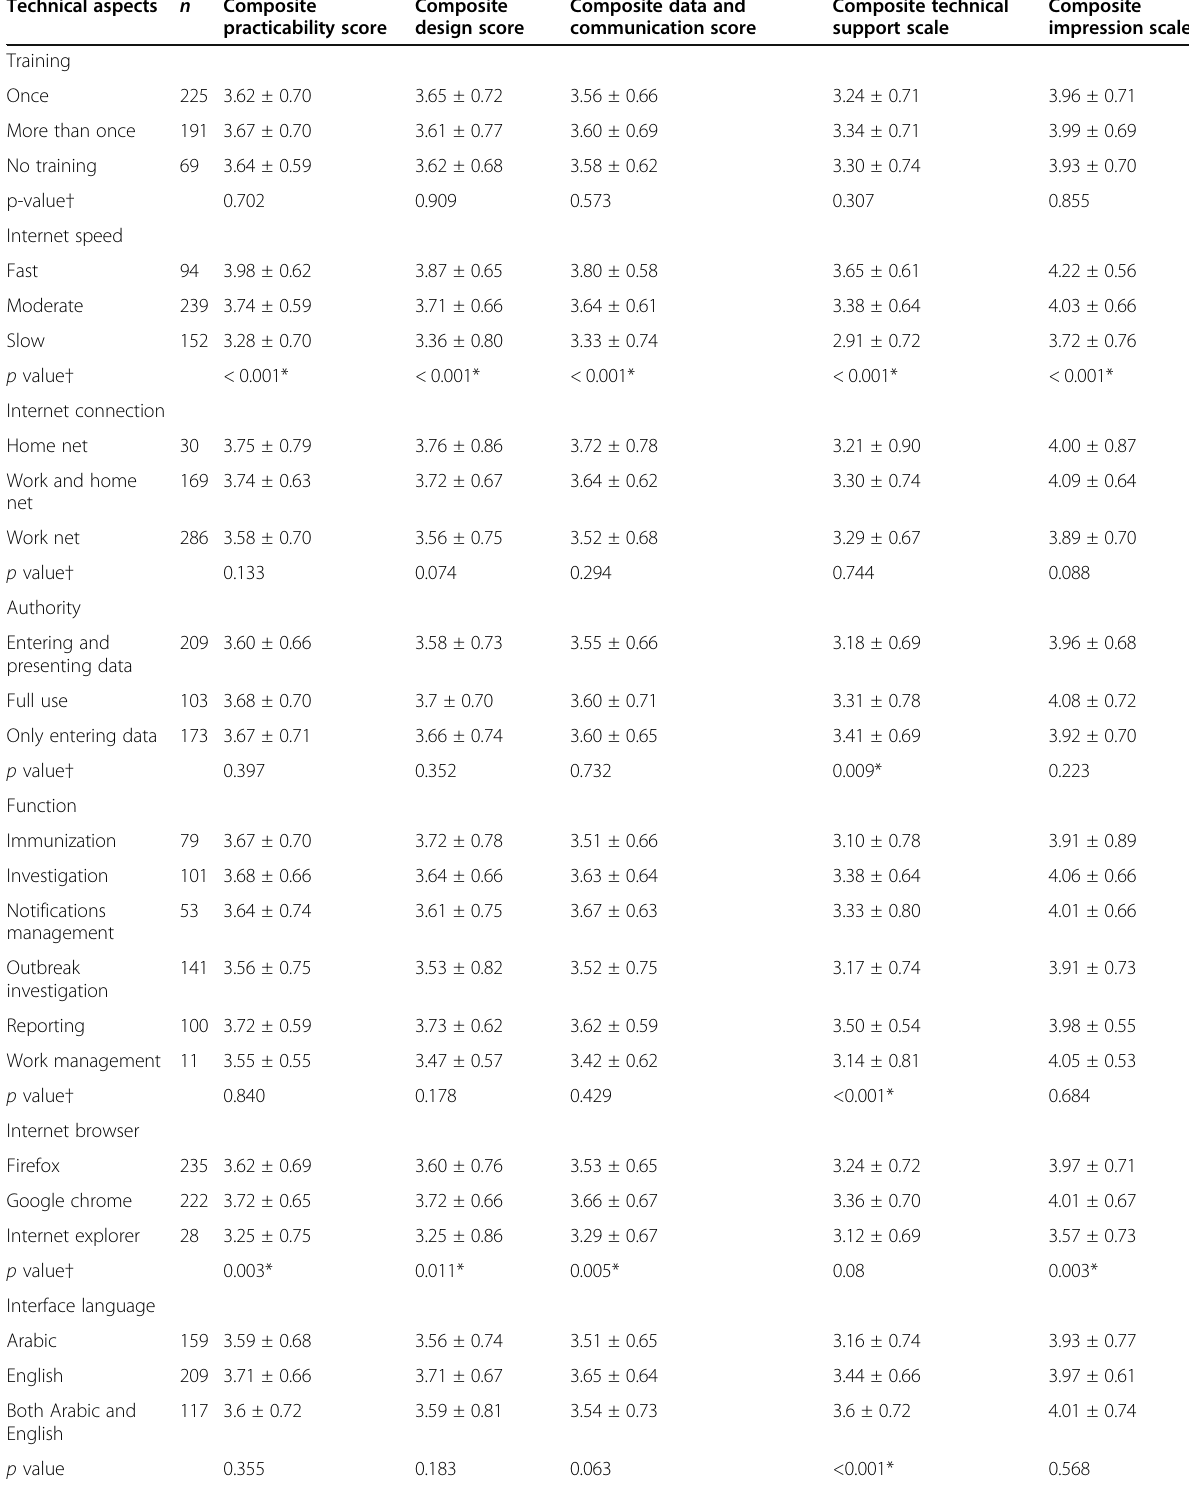
Table 2 Functional and operational aspects of HESN in respect to the composites scores of practicability, design, data and communication, technical support, and general impression, KSA,